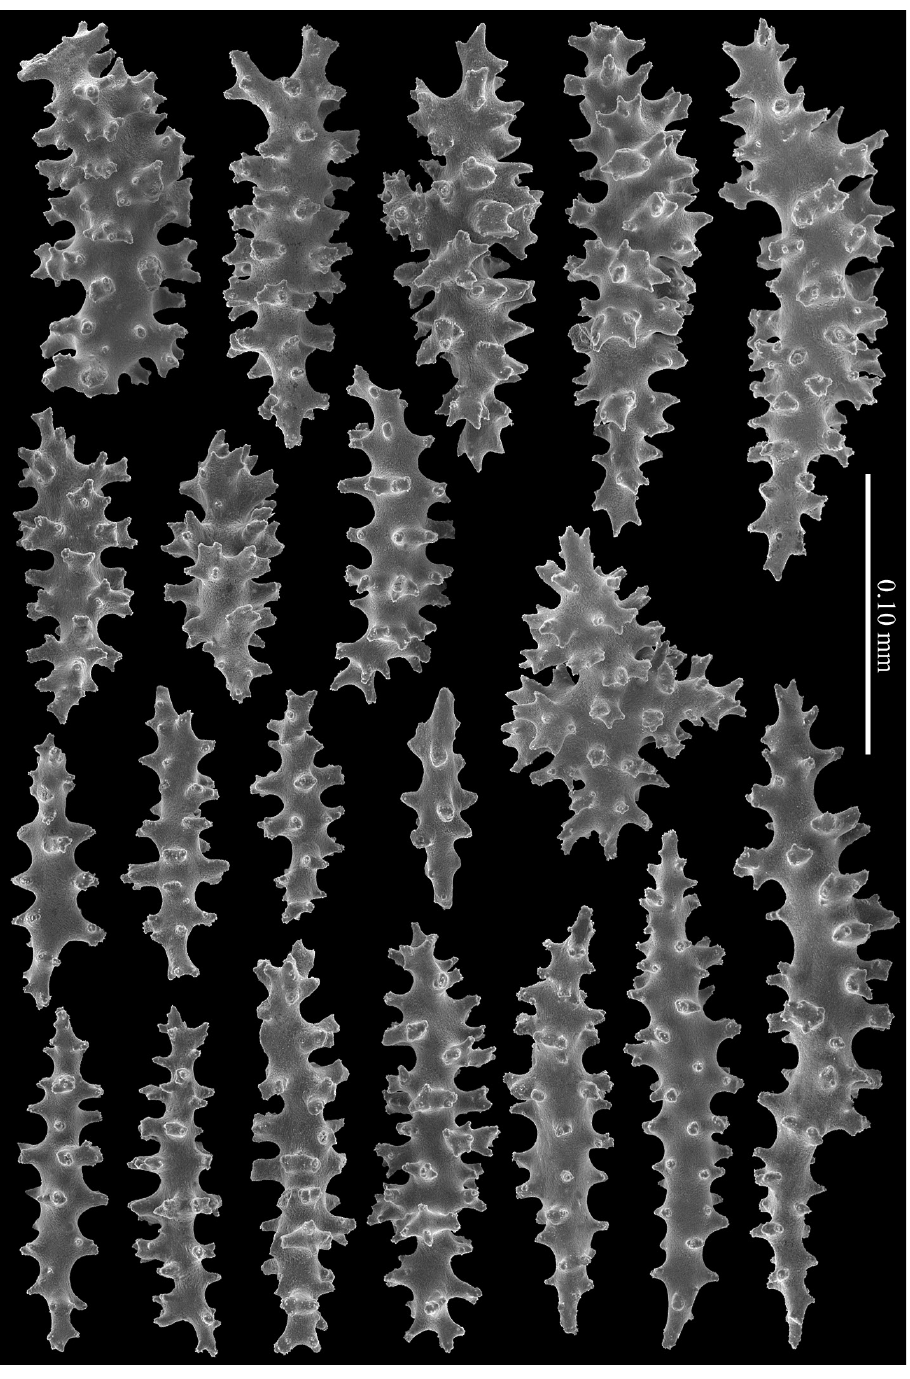
Figure 5. Coenenchymal sclerites of Melithaea davidi sp. n., holotype, RMNH Coel.